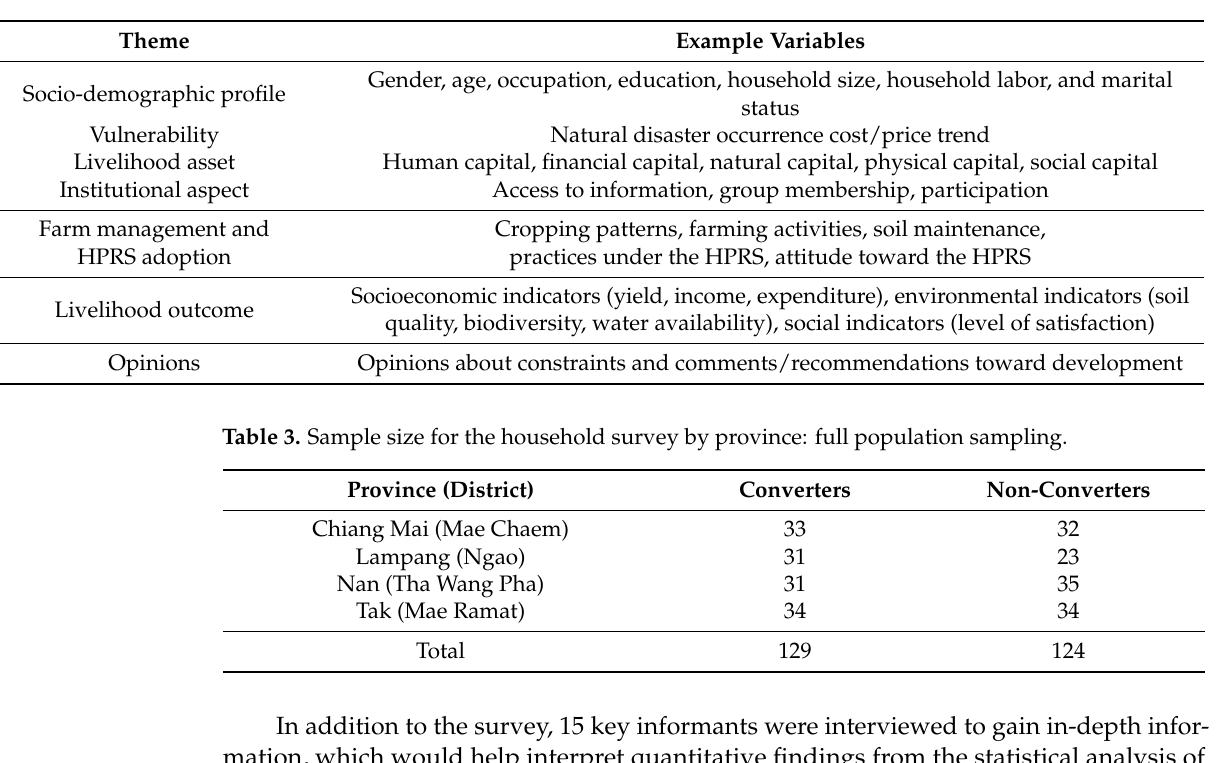
Table 2. Structure of the questionnaire used for the household survey.